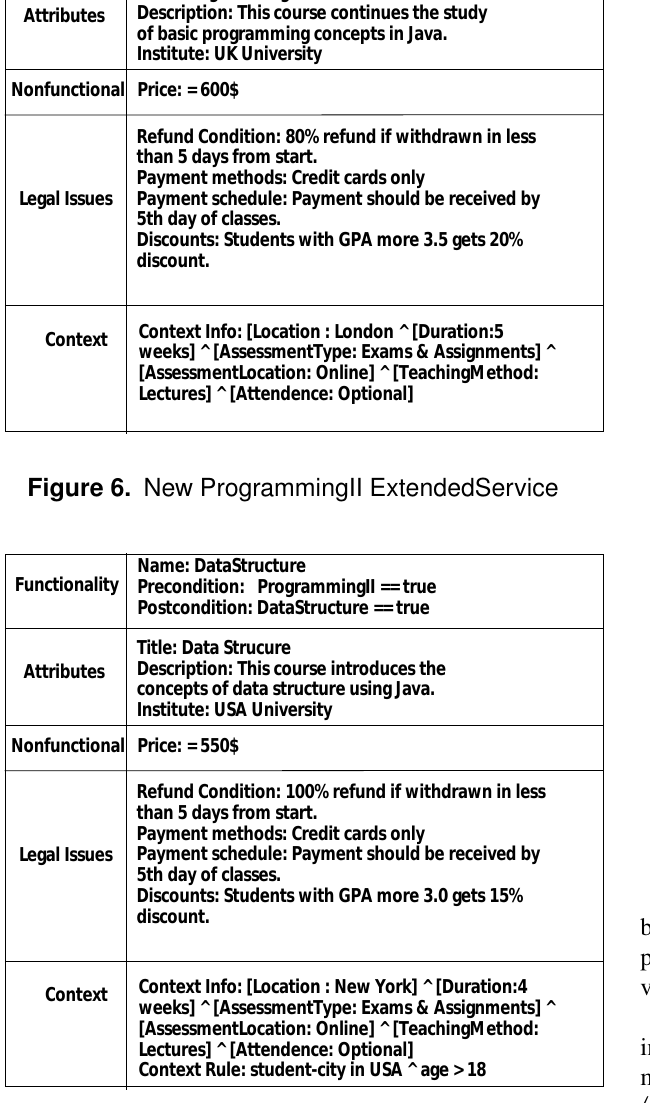
ure 4. The formal notation of the ExtendedService ds is s ds = (cid:104) f ds , κ ds , α ds , l ds , β ds (cid:105) , where the tuple components are explained